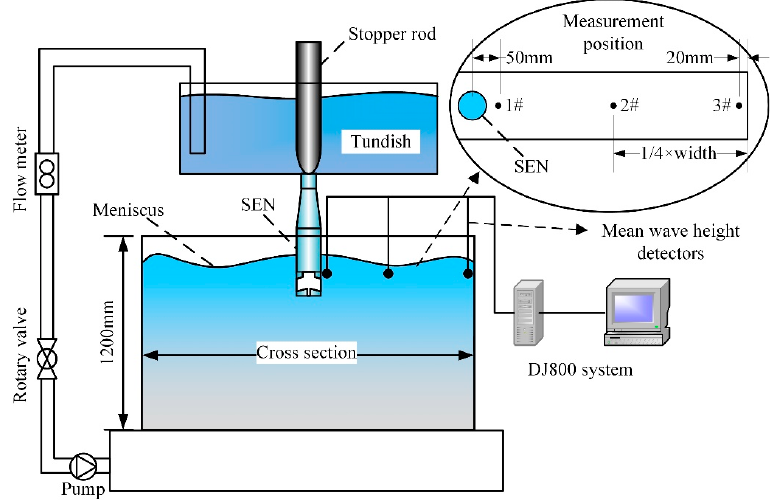
Figure 1. Schematic of the water model and measurement positions of mean wave height.